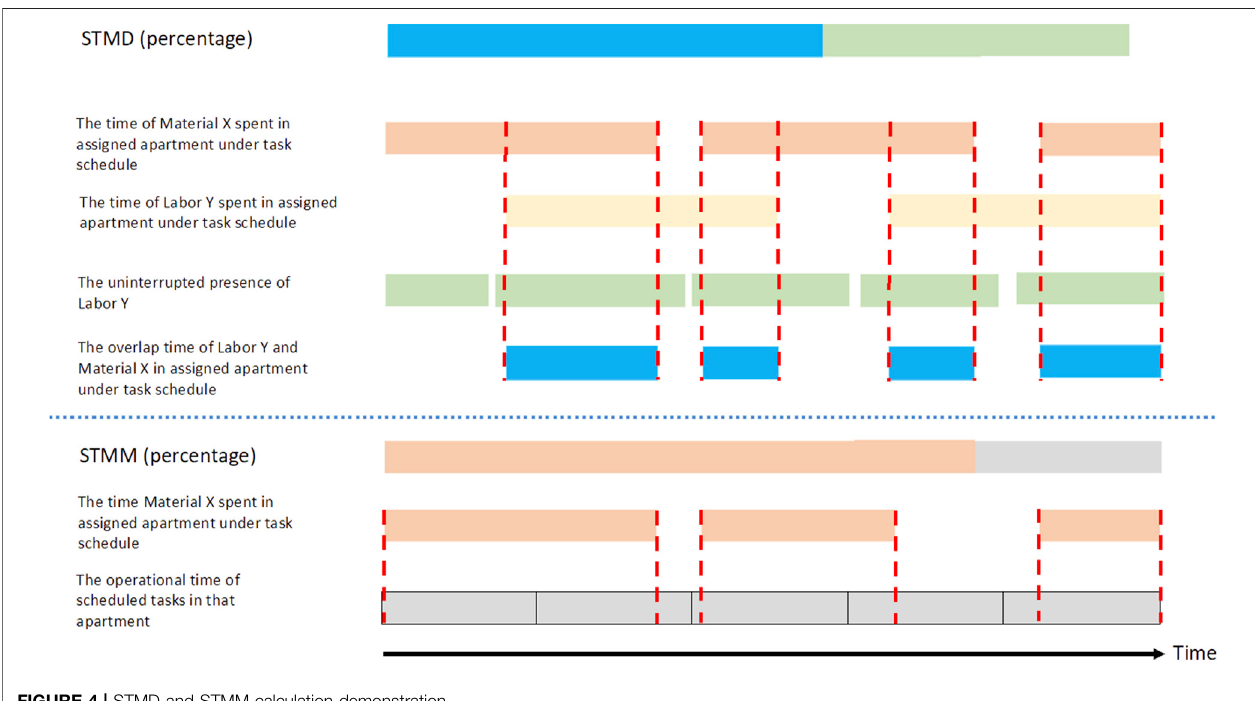
FIGURE 4 | STMD and STMM calculation demonstration.